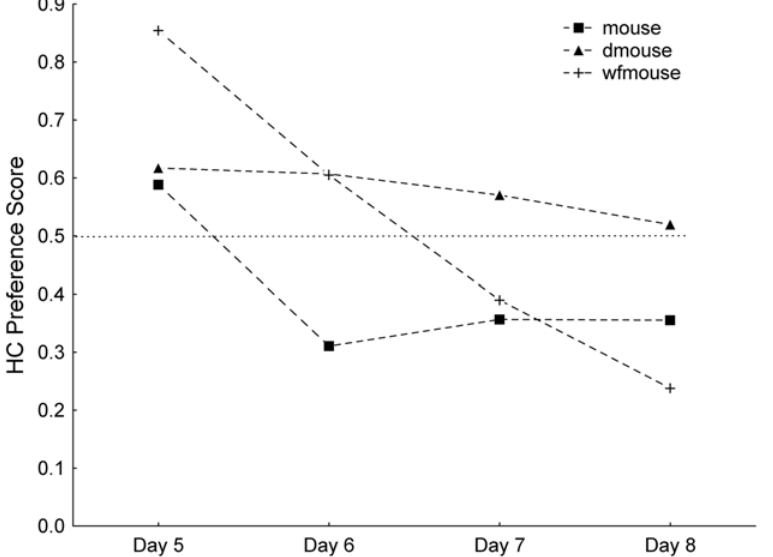
Figure 6. Mouse HC preference scores in follow-up HC v intact casein (C) tests. The dotted line at 0.5 represents indifference between the choices. The four days are labeled Day 5–Day 8 to avoid confusion with the HC v Cel series (Fig. 3).